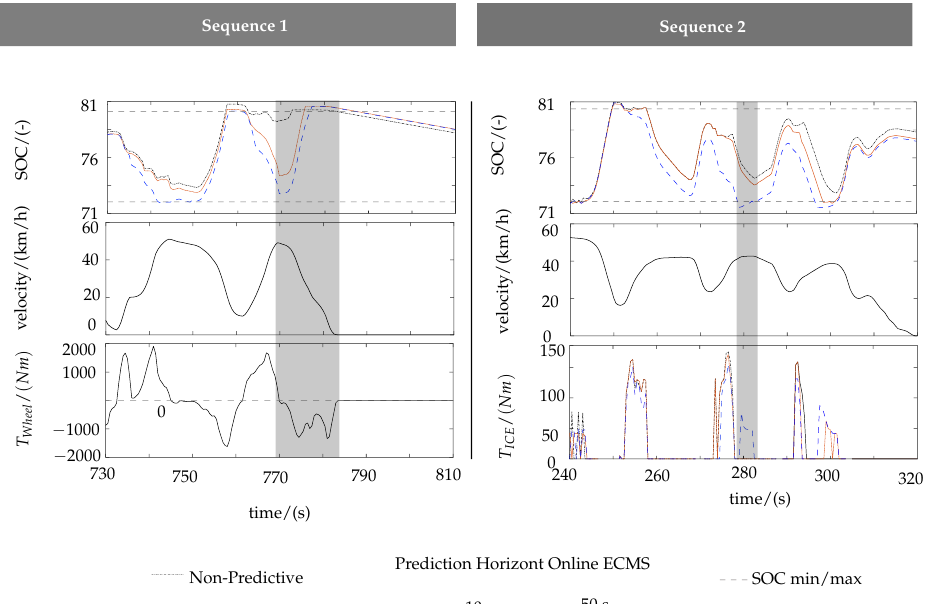
Figure 10. Analysis regarding the prediction horizon of the proposed predictive Online ECMS in two exemplary sequences.